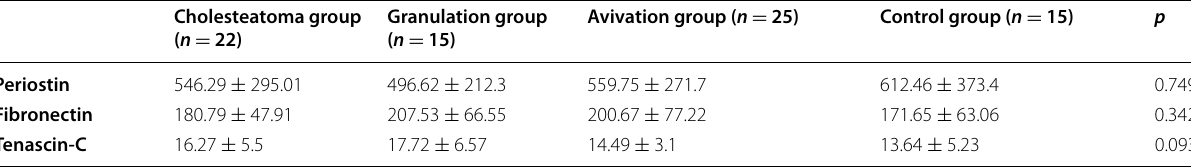
Table 1 Serum periostin, fibronectin and tenascin-C levels of the groups Cholesteatoma group ( n =